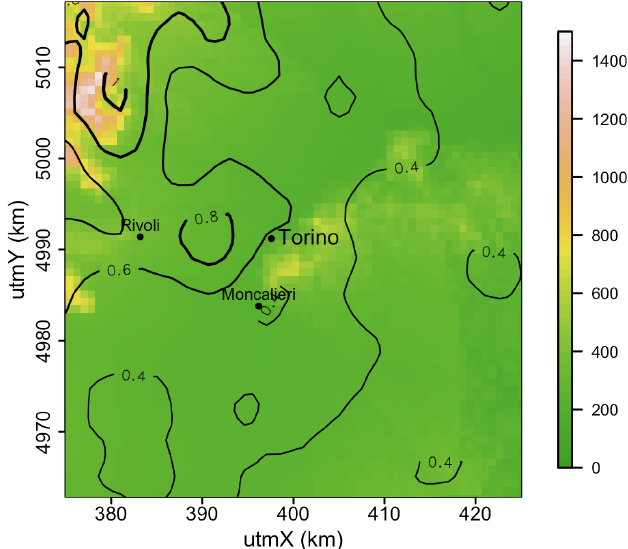
Figure 10. Spatial distribution of IDs density over the Torino area (contour lines) overplotted over topography (color